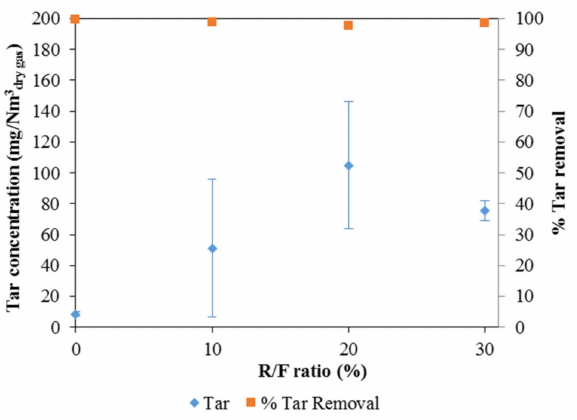
Figure 13. Influence of R/F ratio on the gravimetric tar concentration in the product gas. Tar concentration increased with the share of RDF from 0% R/F to 20% R/F, while the tar concentration decreased with increasing the RDF from 20% R/F to 30% R/F. This phenomenon could be due to the synergistic effect of the co-gasification of RDF and wood chips and/or the synergistic effect of the ash in the RDF and the ash in the wood chips.